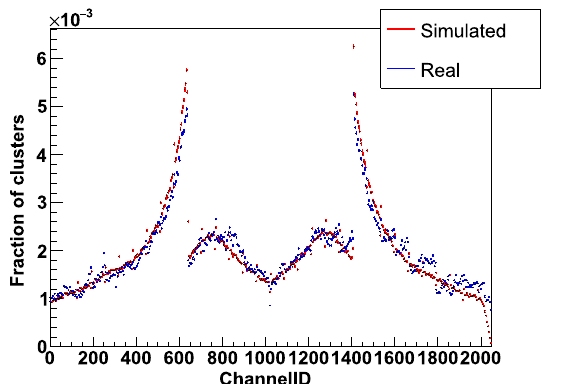
FIG. 11. Measured (blue points) and MC simulated (red points) SciFi cluster distribution along a SciFi module.